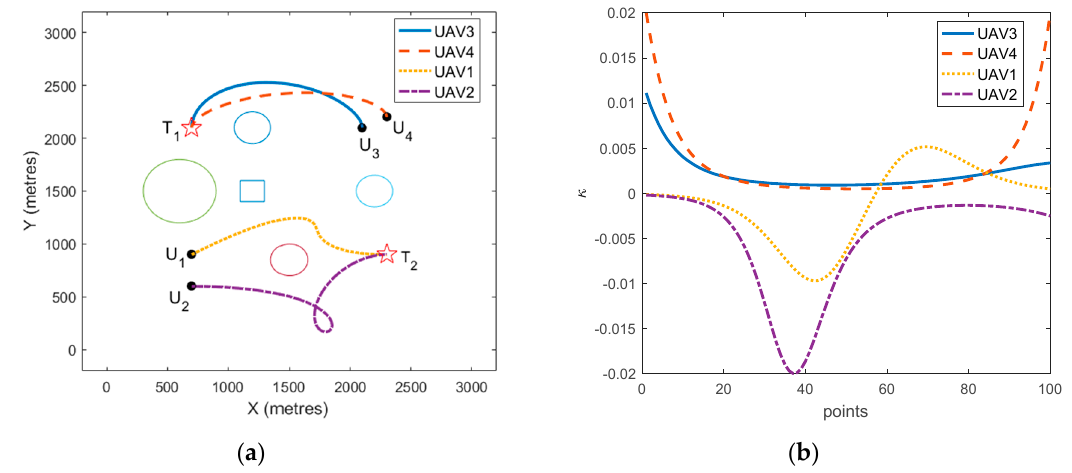
Figure 5. ( a ) Mission planning results (Pythagorean hodograph (PH) curve is used in the path estimation process); ( b ) curvature of each UAVs’ path.